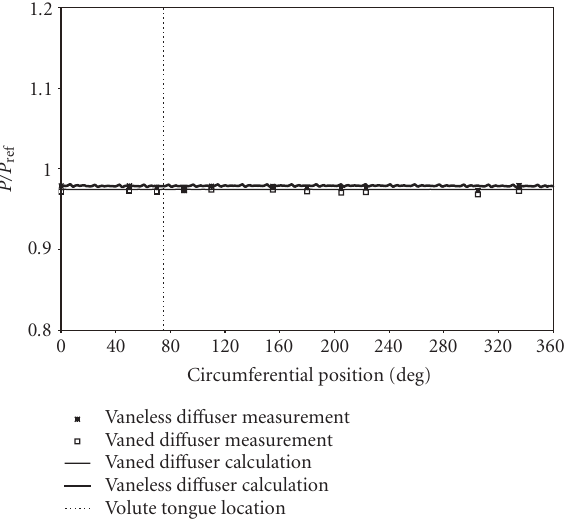
Figure 4: Spectra of compressor and condensor vibration and force on compressor internal surface for the vaned di ff user case at design conditions.